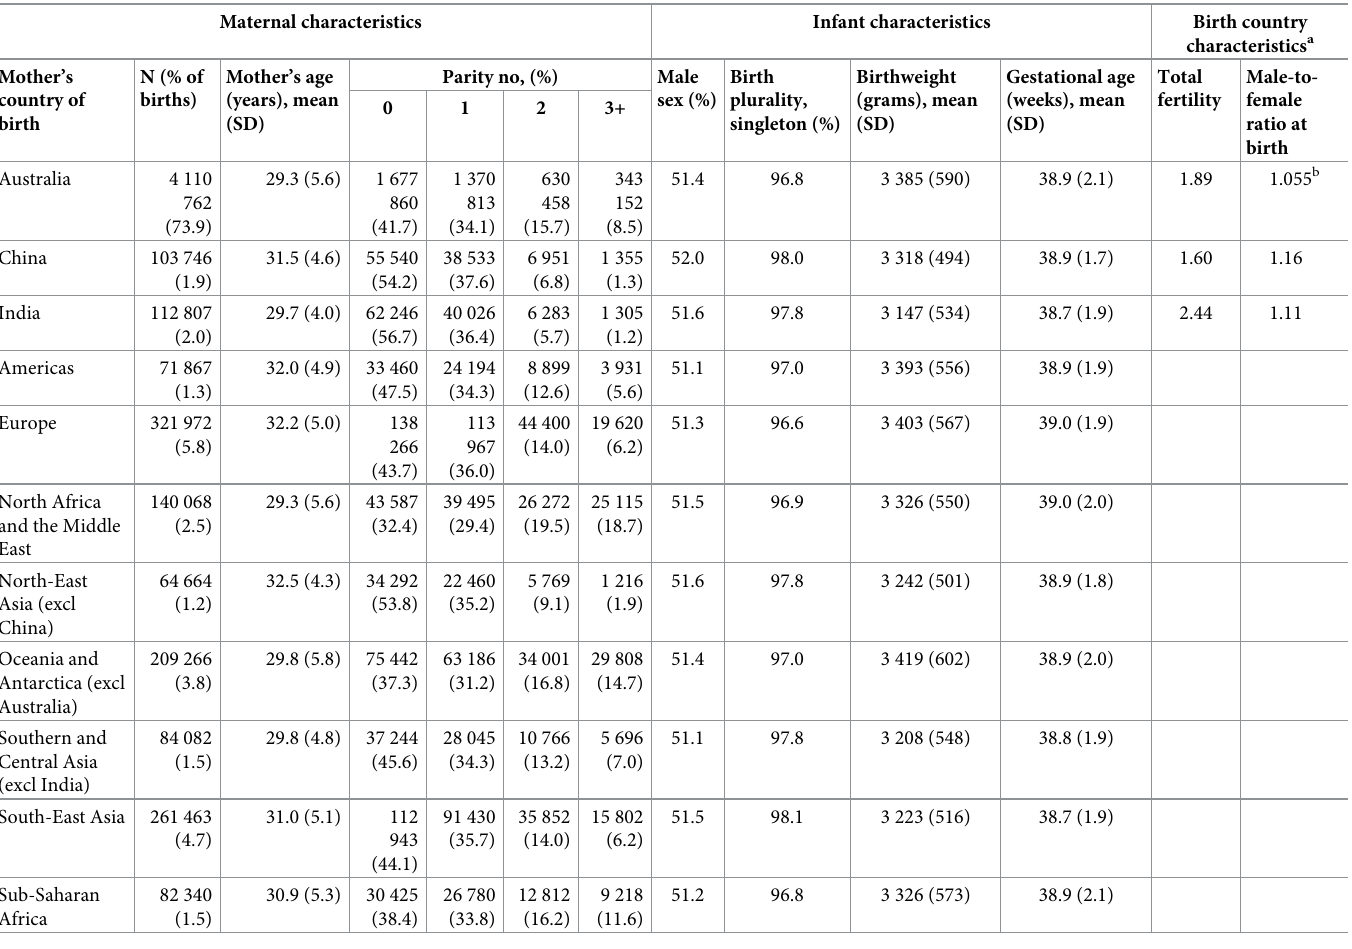
Table 1. Maternal, infant and birth country characteristics of mothers giving birth in Australia